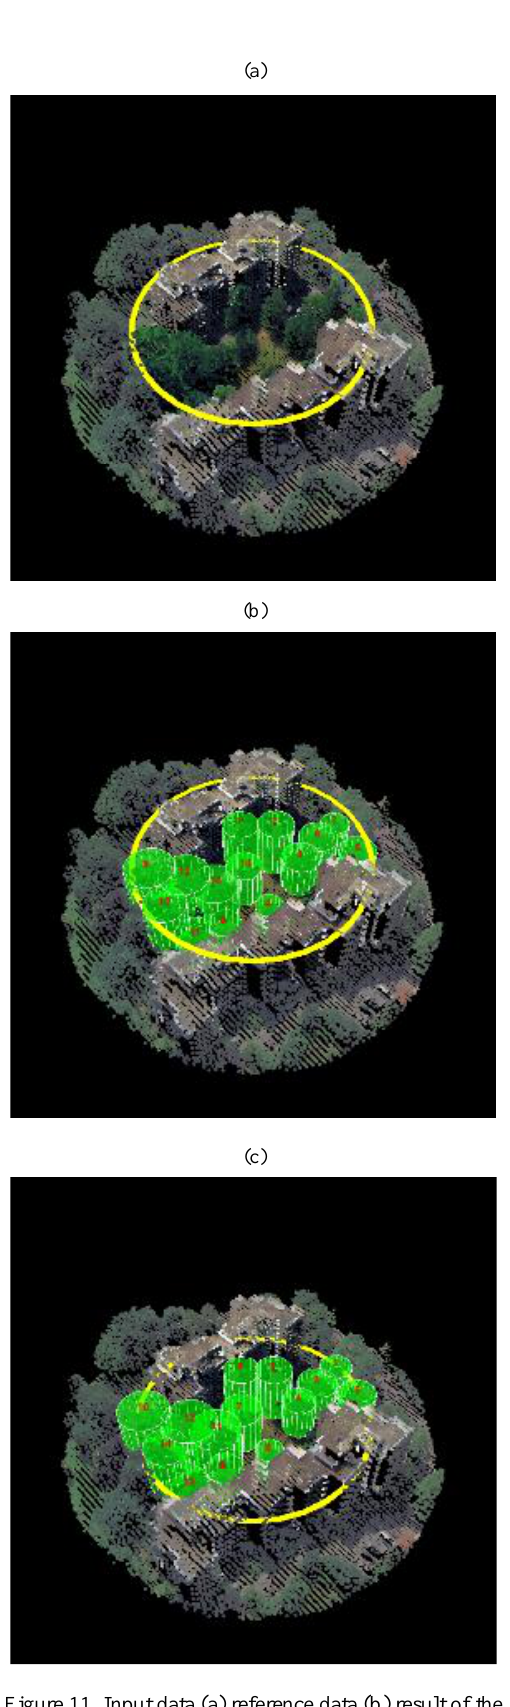
Figure 11. Input data (a) reference data (b) result of the integration (c) of one example data section of the V3D